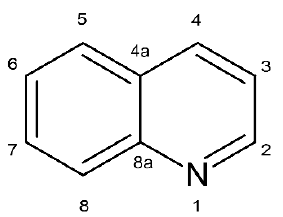
Figure 1. Chemical structure of quinoline.